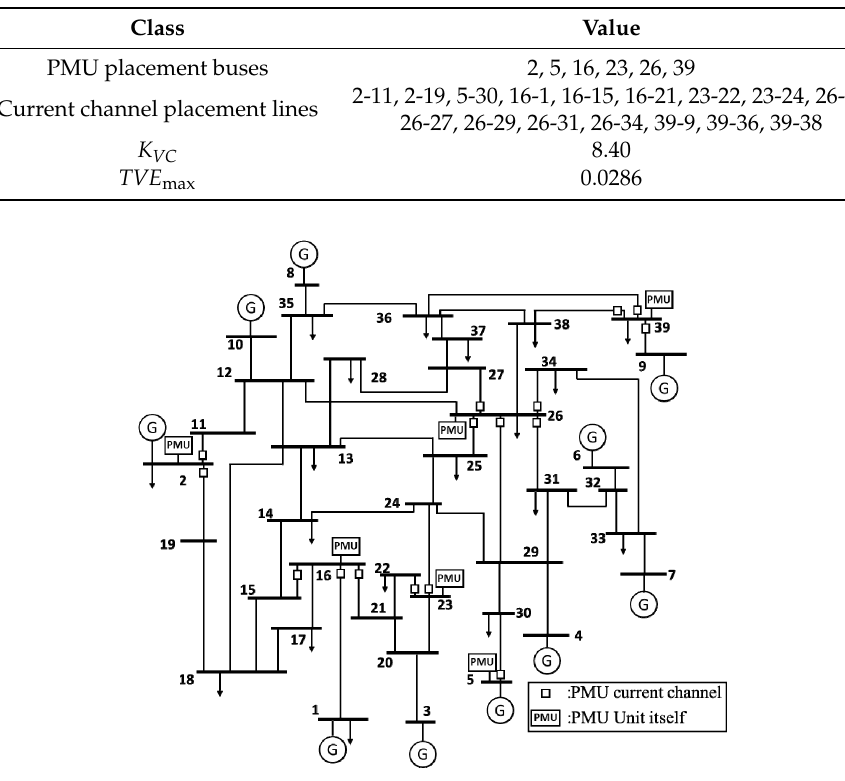
Figure 6. The actual PMU placement of the BCS in modified NE